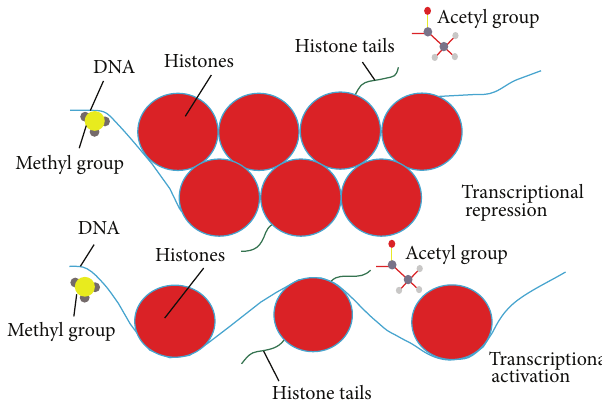
Figure 1: Epigenetic mechanisms. DNA is wrapped around proteins called histones; this forms the core DNA package called the nucleosome. When the DNA is tightly wrapped, transcription factors cannot bind and transcription is repressed. When the DNA is more loosely wrapped, transcription is more active as transcription factors can bind. DNA methylation is when a methyl group is added to the DNA strand and is associated with transcriptional repression [58]. Histone acetylation is the addition of acetyl groups to the histone tails and this is associated with transcriptional activation. Histone deacetylation is the removal of acetyl groups which is associated with transcriptional repression